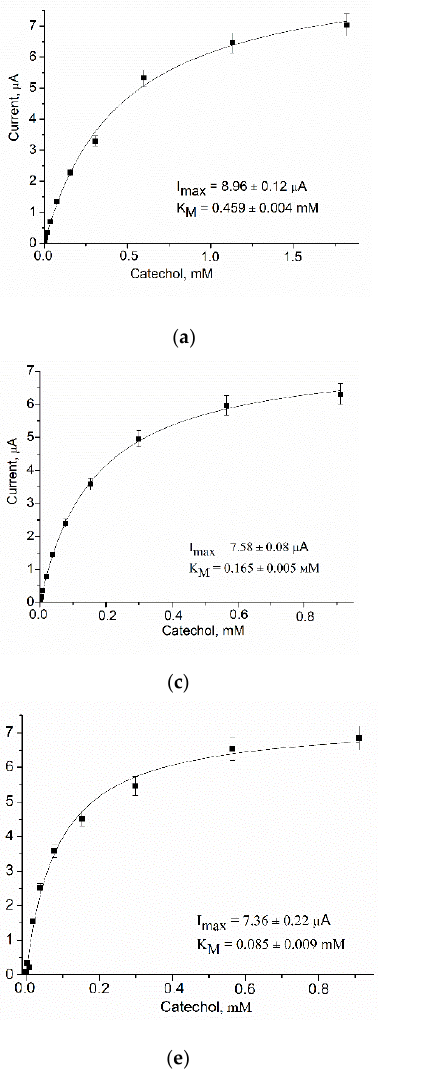
Table 1. Analytical characteristics of the constructed bioelectrodes.